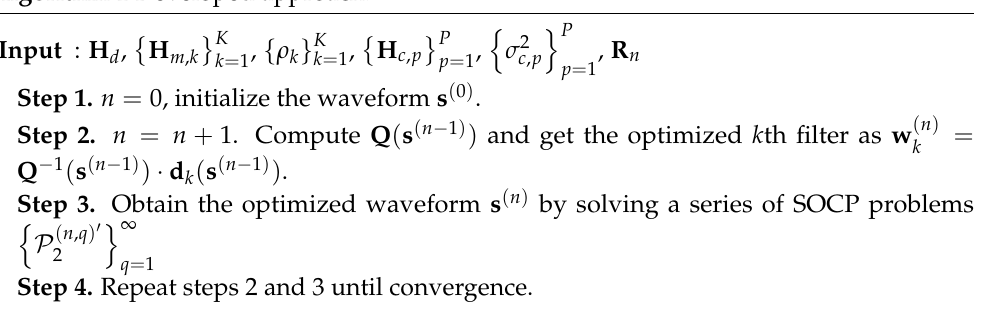
Algorithm 1 Developed